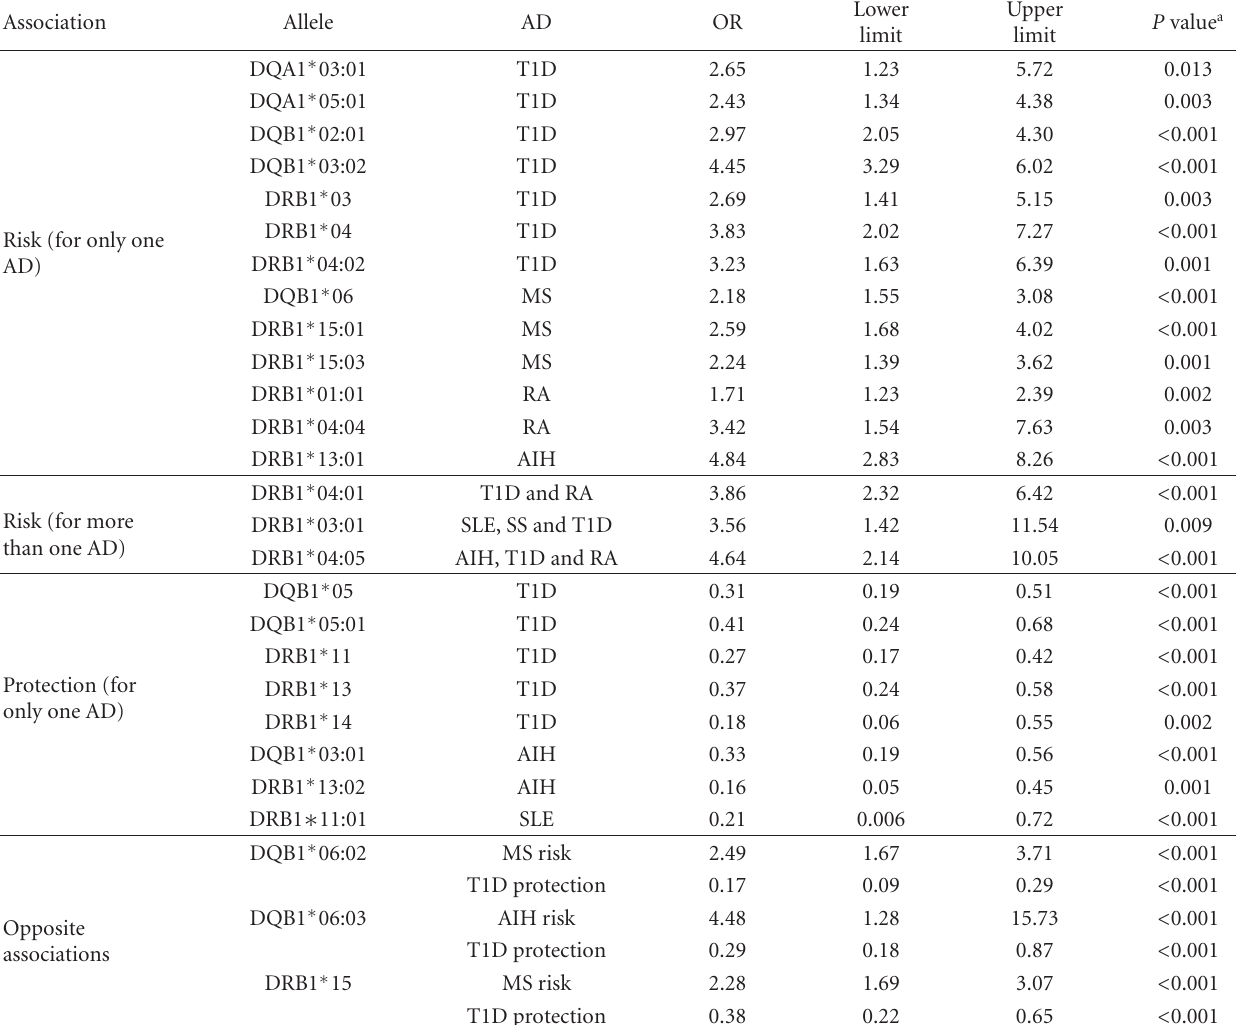
Table 1: Associations between HLA class II and six ADs: SLE, RA, T1D, AIH, SS, and MS.